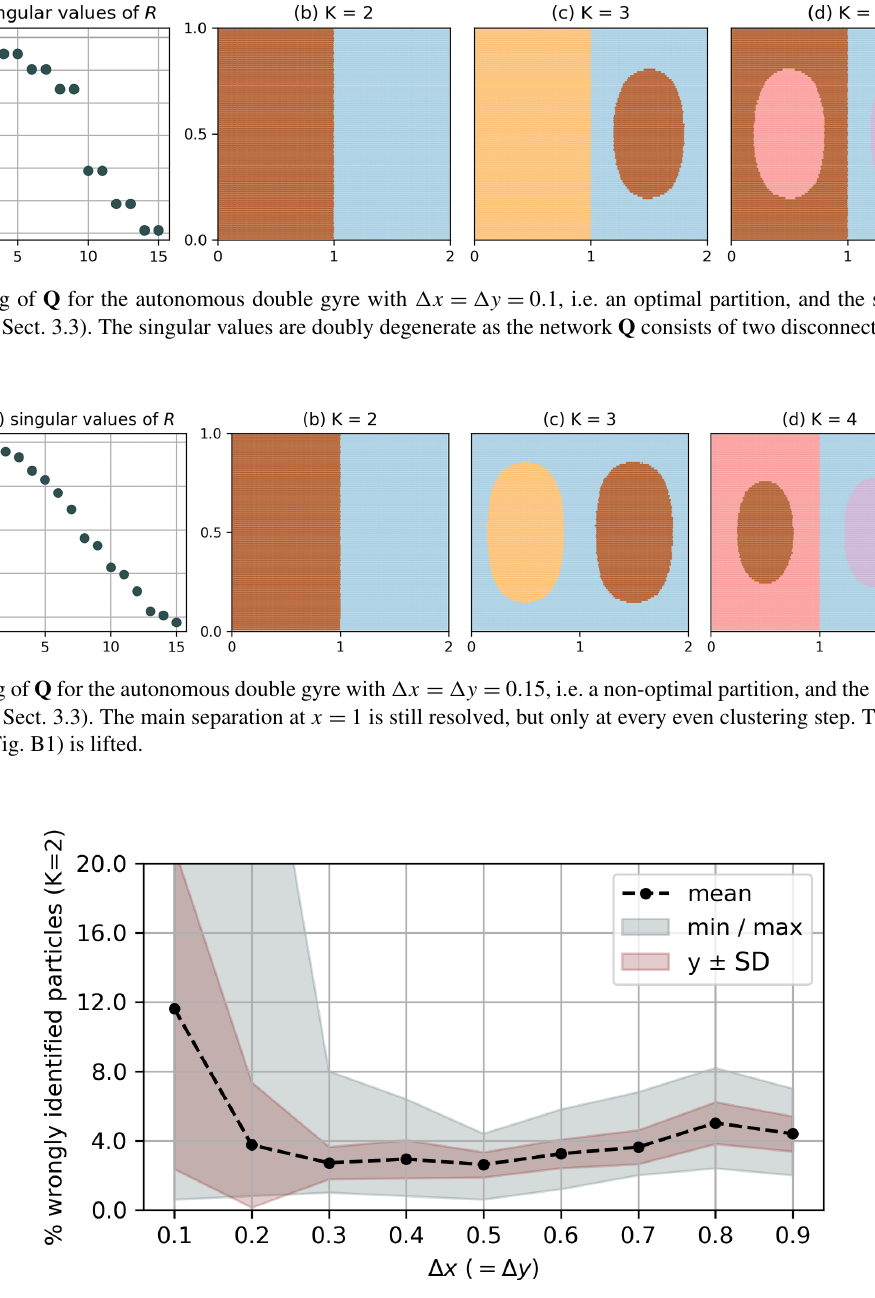
Figure B3. Share of incorrectly assigned particle labels for the double-gyre flow (simultaneous K -way clustering) for varying (cid:49)x = (cid:49)y , K = 2 and the incomplete ( N = 500) data set, compared to the baseline of the complete data set with (cid:49)x = (cid:49)y = 0 . 04; cf. Fig. 3. The values were obtained with 100 random incomplete data sets for each value of (cid:49)x ( = (cid:49)y ). The filled areas show the minimum and maximum ranges, 1 standard deviation, and the points the corresponding means. It is visible that for too small bin spacing, the number of wrongly assigned labels is very high. This is most likely because the network becomes less connected, such that it is more difficult to find structure in the eigenvector corresponding to the second smallest eigenvalue of L s [ Q ] . As explained in the main text, for bin sizes that do not exactly fit the domain, the x and y directions were artificially